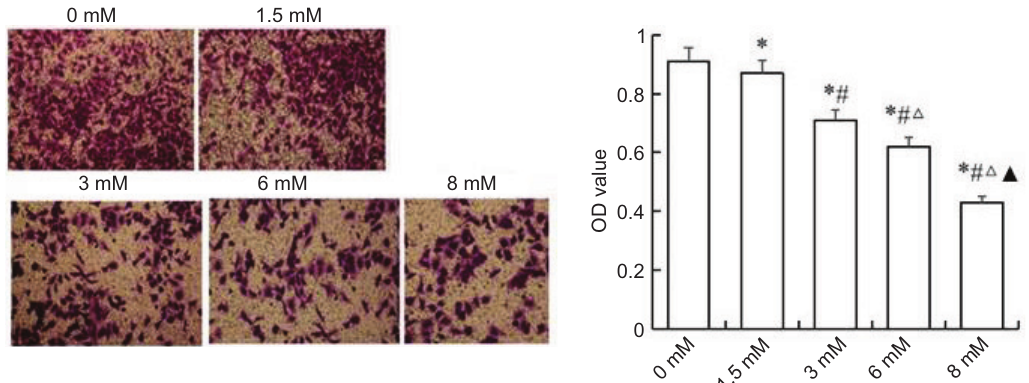
Figure 4: Cell migration analysis by transwell assays. ligustrazine significantly reduced the ability of A498 cells migration in a dose-dependent manner.